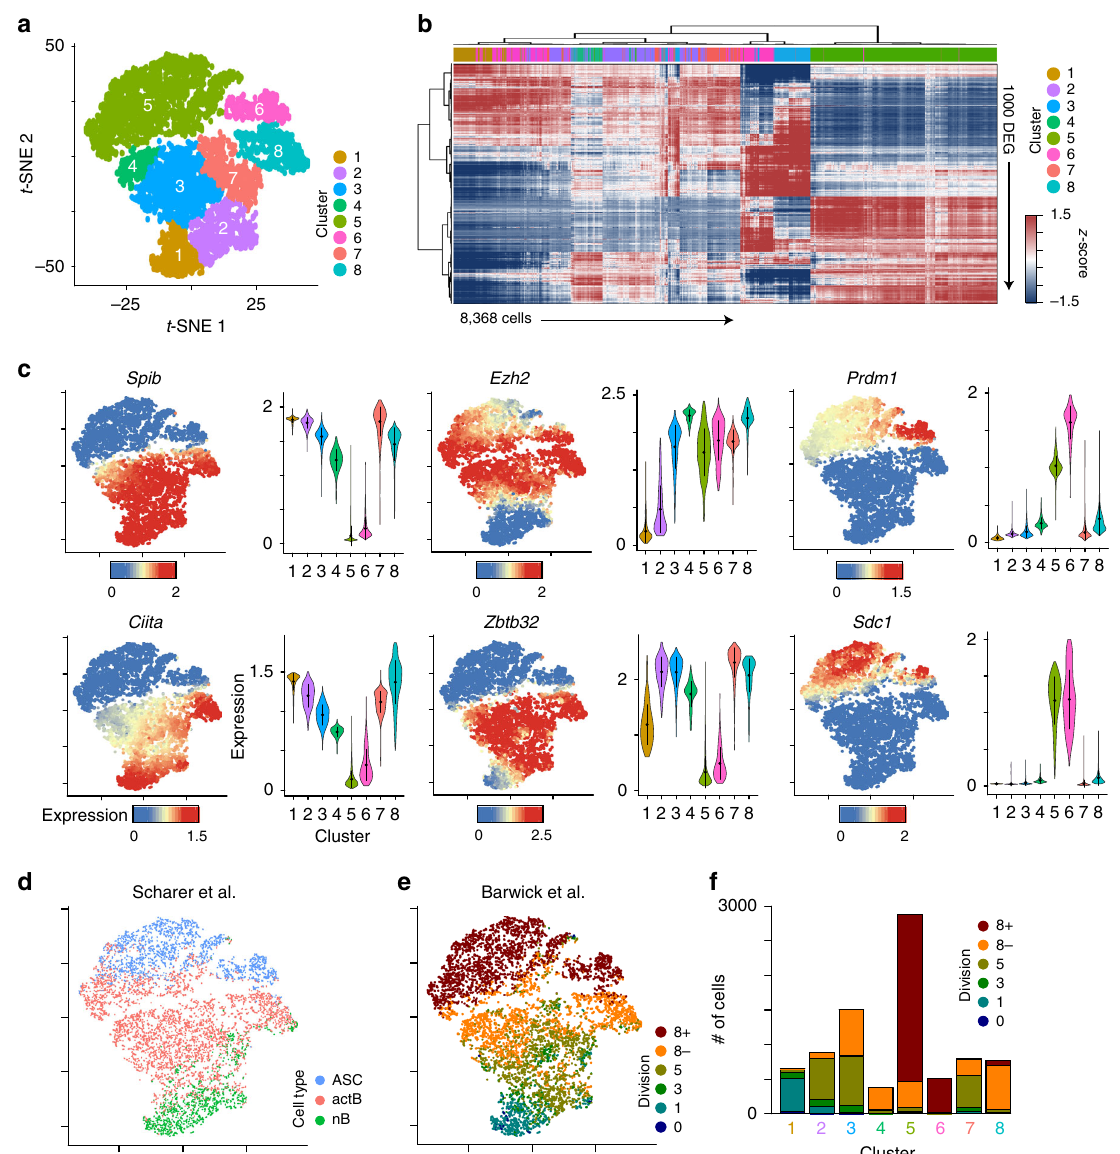
Fig. 4 scRNA-seq reveals a continuum of heterogeneous LPS-responding B cells. a t -SNE plot of 8368 WT cells responding to LPS showing eight distinct clusters of cells. b Heatmap showing hierarchical clustering of the top 1000 differentially expressed genes (DEG) between cells in each of the eight clusters from ( a ). Data represent z -score normalized MAGIC expression values. c t -SNE plot (left) from ( a ) and violin plots (right) for each cluster showing the MAGIC gene expression data for the indicated gene. For violin plots, the dots represent the mean and lines represent fi rst and third quartile ranges. d t -SNE plot from ( a ) showing the annotation of each cell with naïve B cells (nB) and ex vivo differentiated activated B cells (actB) and ASC from Scharer et al. 14 . e t -SNE plot from ( a ) showing the annotation of each cell with division sorted LPS-responding B cells from Barwick et al. 16 . f Bar plot quantitating the number of cells from each cluster annotated to speci fi c divisions in ( e ). Data represent combined cells from two independent mice. Source data are provided as a Source Data fi correlation between the data. Representing the non-ASC branch, enzymes 34 (Fig. 5g, h). Examples of genes upregulated in cluster 6 cluster 7 cells were enriched for IRF9 and BACH2 expression and included Atf6 , Hspa5 , and Calr (Fig. 5i). Although both clusters 5 activities. Conversely, cluster 3 cells in the ASC-destined branch and 6 have upregulated the ER stress response factor Xbp1 , these were enriched for KLF10, E2F1, and BATF activities. Batf was data suggest that ASC in cluster 6 were under distinct ER stress. more highly expressed in clusters 3 and 4 compared to 7 and 8 and BATF target genes largely re fl ected this pattern of activity (Fig. 6b, c). Analysis of BATF target gene expression along pseudotime revealed that the majority were induced early and ultimately repressed and included Aicda , Junb , Rela , Myc , and Batf itself (Fig. 6d). This is consistent with evidence that BATF- de fi cient B cells proliferate but cannot class switch due to a failure to induce Aicda 36 . Further analysis of the BATF motifs identi fi ed